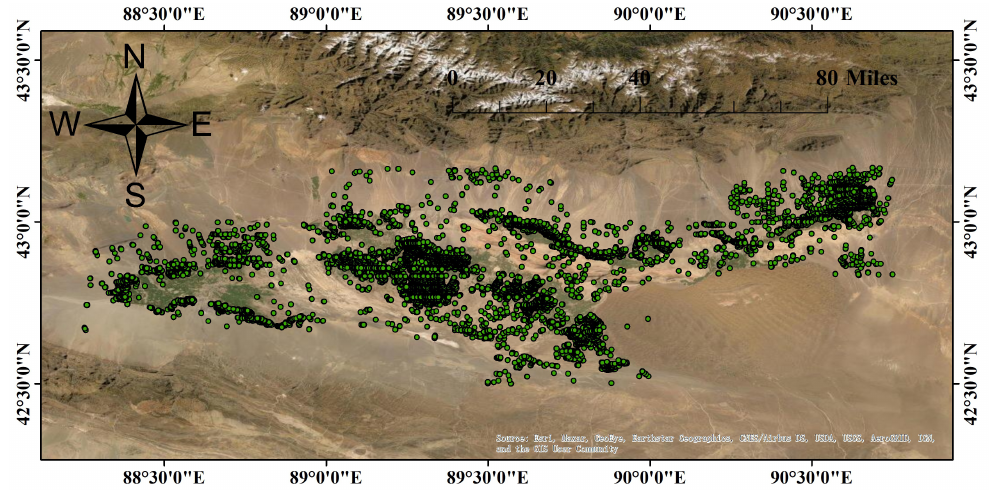
Figure 12. Karez shaft of Turpan Basin obtained by YOLOv5 and post-processing, the solid green points with black boundaries are the karez shafts retained after the post-processing step; the base map is World-Imagery in ArcGIS.